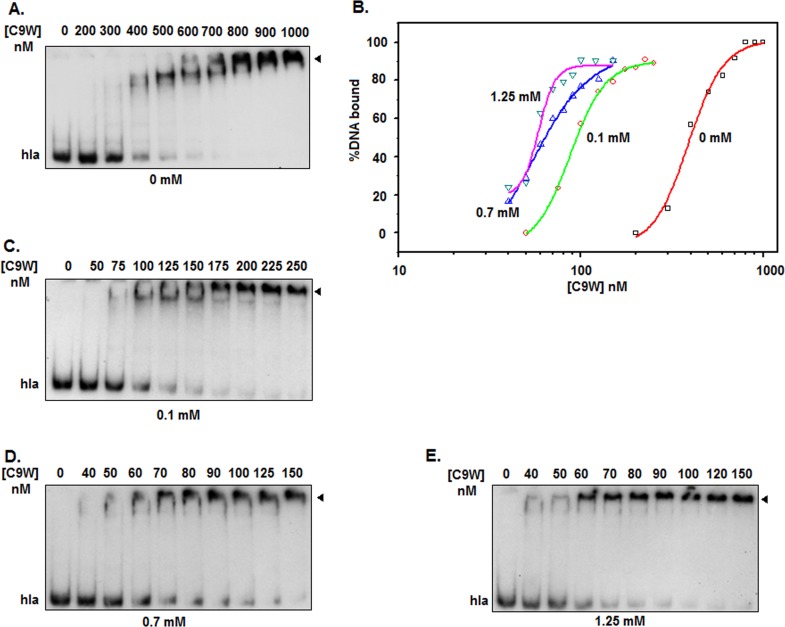
DNA binding activity of C9W at 0–1.25 mM TX-100.(A) Autoradiogram of the gel shift assay shows the equilibrium binding of C9W to the 32P-labeled hla DNA in the presence of 0 mM (A), 0.1 mM (C), 0.7 mM (D), and 1.25 mM TX-100 (E). Arrowhead represents the C9W-hla DNA complex. All of the assays are carried out at least three times. One set of autoradiograms are presented here. (B) DNA binding activity of C9W. The extents of C9W bound to hla DNA in the presence of denoted concentrations of TX-100 are estimated (from the data of the above autoradiograms) and plotted against the corresponding C9W concentrations.